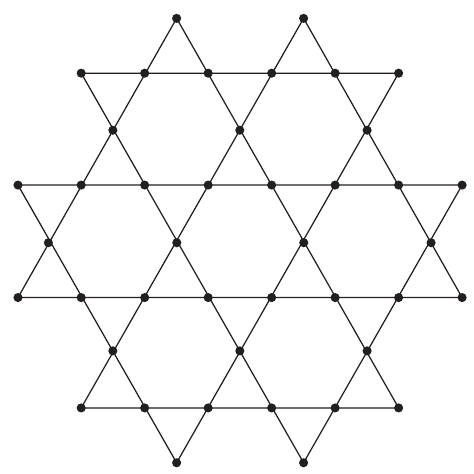
Figure 3: An oxide network OX